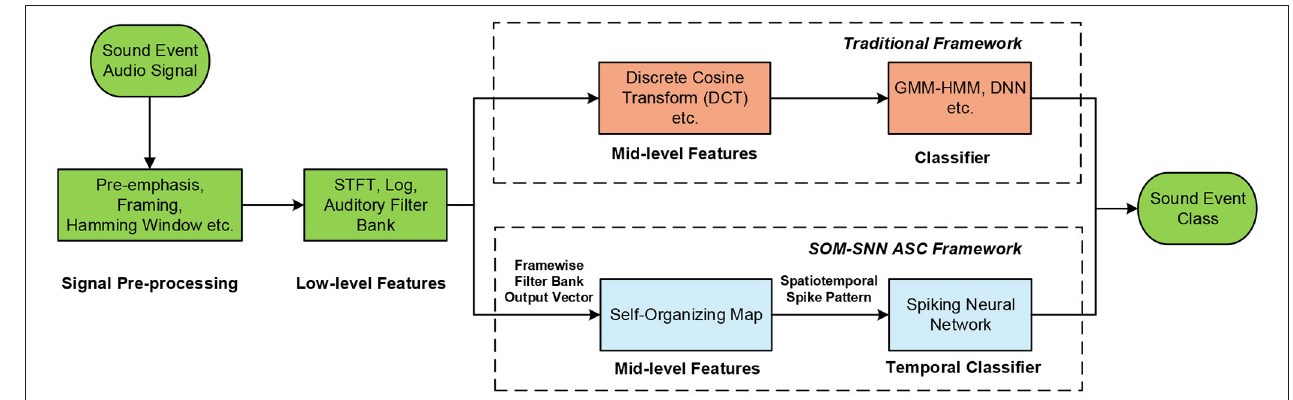
FIGURE 1 | Overview of the proposed SOM-SNN ASC framework, which uses the SOM as a mid-level feature representation of frequency contents in the sound frames, and classifies the spatiotemporal spike patterns using